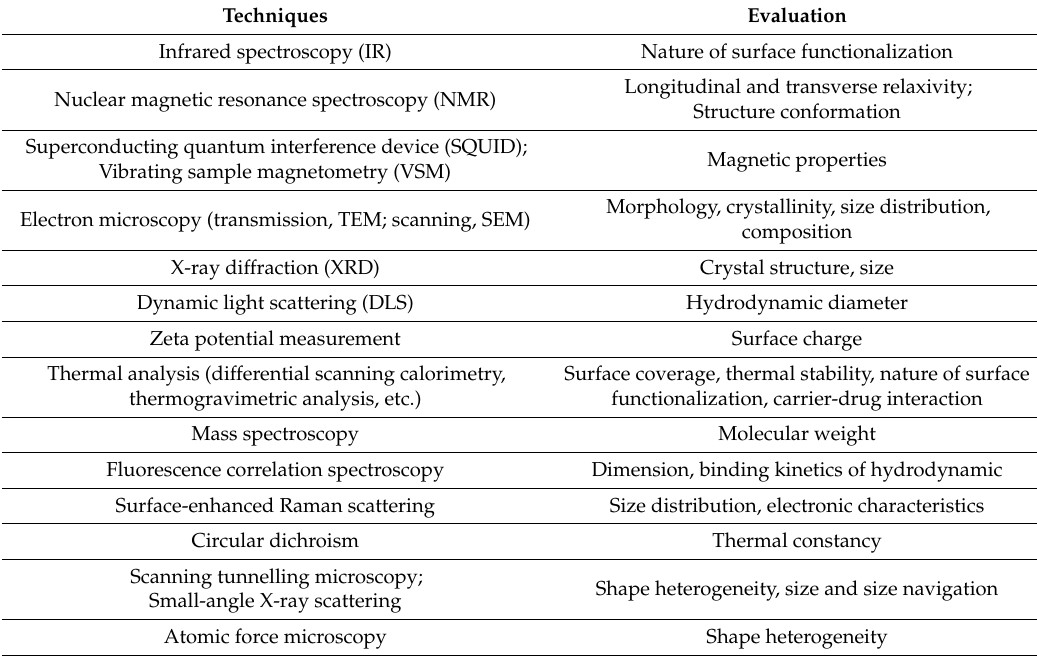
Table 2. Characterization techniques used to evaluate physicochemical properties of